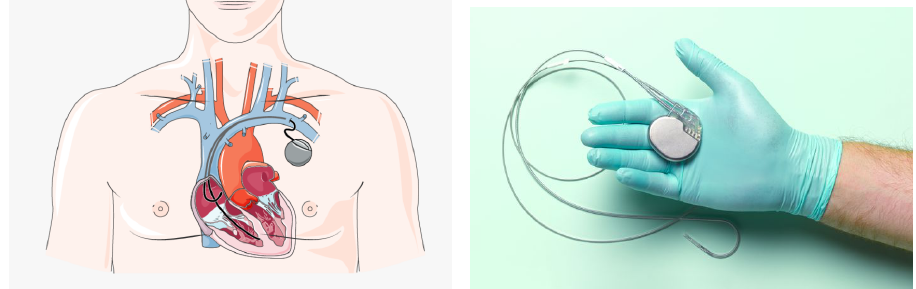
Figure 1. Cardiac Pacemaker